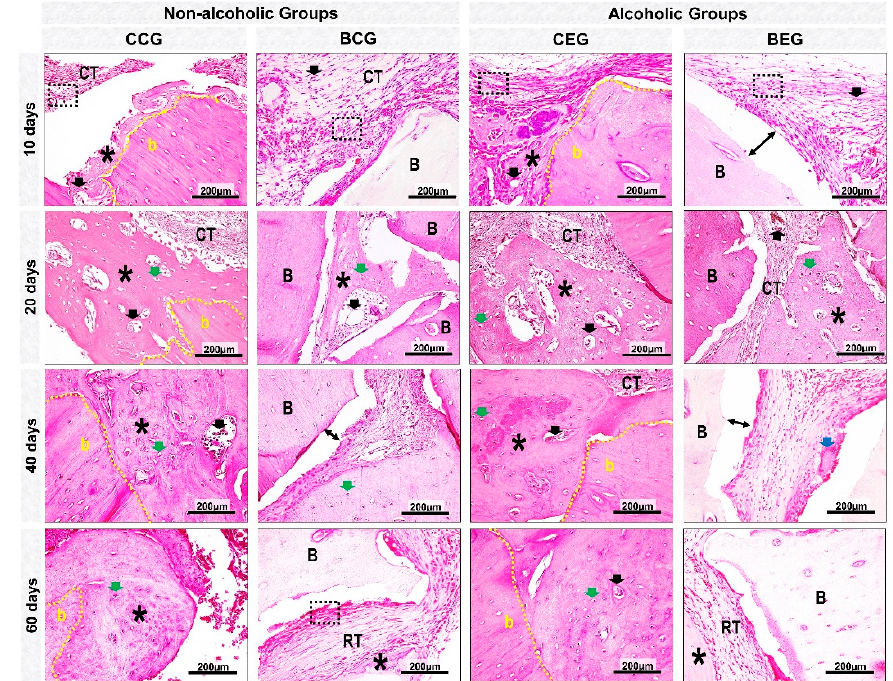
Figure 5. Histological details with HE staining of evolution of cranial defect bone healing created in the Non-Alcoholic and Alcoholic animals treated with blood clot or biomaterial. At 10-20 days, CCG and CEG showed the presence of richly vascularized connective tissue (CT) (black arrow) and new bone tissue (asterisk) at the defect margin (b) with trabecular arrangement. All groups presented inflammatory cells (inside the black lined area), more evident in BCG and BEG, permeating the particles (B). At 40 days there was typical lamellar arrangement, interspersed with osteocytes (green arrow), and in BCG and BEG inflammatory cells and multinucleated giant cells (blue arrow). At 60 days, bone tissue was mature and compact in defects filled with blood clot, there was decreased inflammatory reaction in BCG and BEG groups and regularly organized collagen fibers. Artifacts in histologic sections (double arrow–gap between biomaterial and tissue). HE; original magnification x 40; bar = 100 µm.